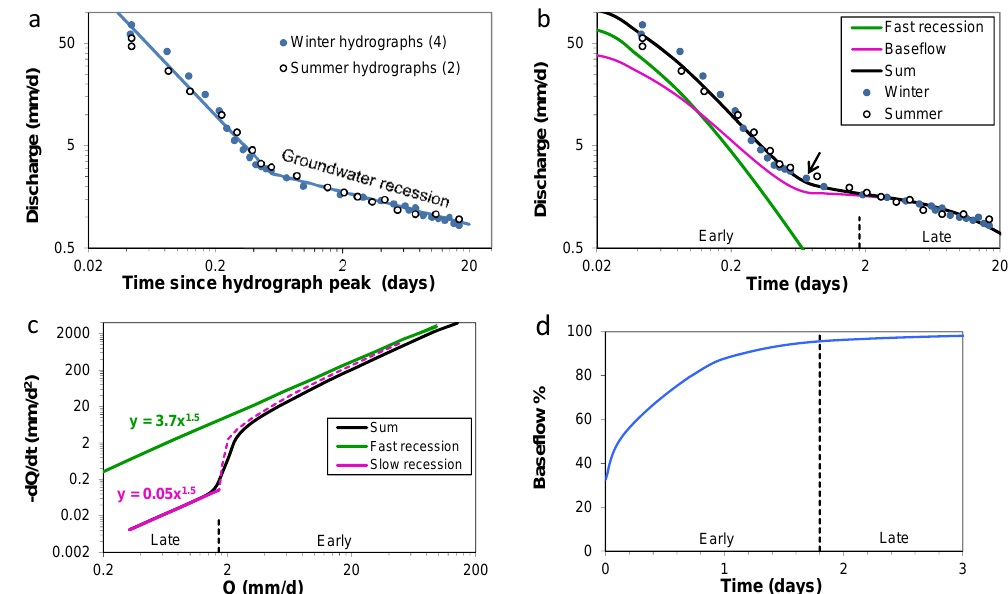
Figure 6. (a) “Master” recession curve for Glendhu GH1 Catchment (redrawn from Pearce et al., 1984). (b) Master recession data matched by the sum of the baseflow and a fast recession curve. The arrow shows the inflexion point. Early and late parts of the master recession curve are shown. (c) Recession plot of master recession curve (sum), baseflow and fast recession. The sum is close to the fast recession curve at high flows and close to the baseflow (slow recession curve) at low flows. The dashed part of the curve shows the “bump” in the baseflow; (d) variation of the baseflow contribution to streamflow with time during the master recession